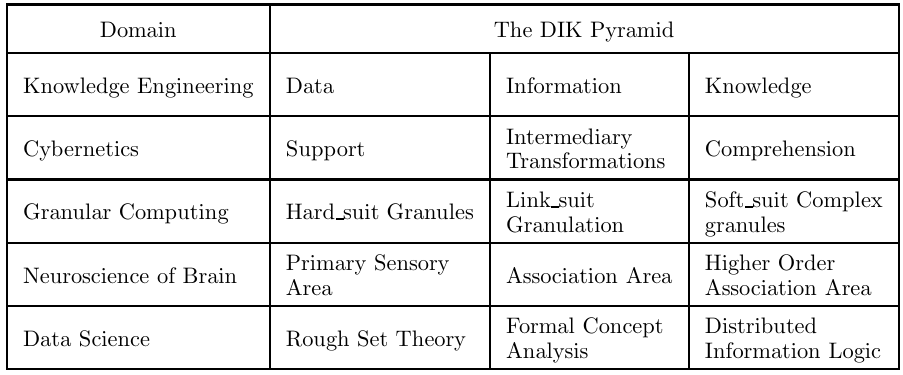
The universal nature of Data-Information-Knowledge (DIK) Hierarchy (every intelligent system acquires knowledge by the transformation of data into